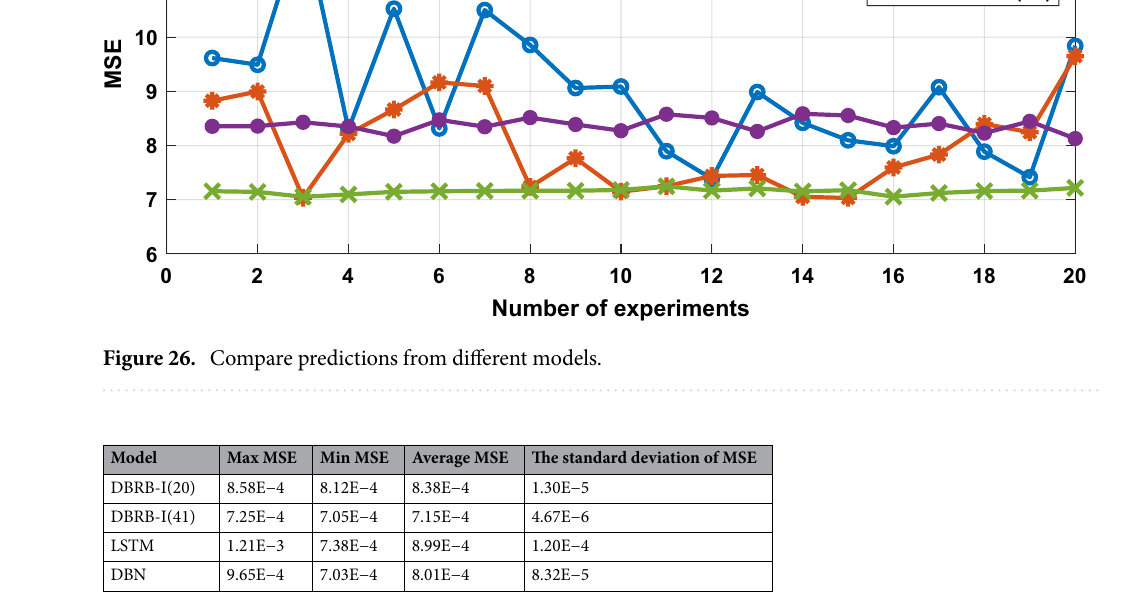
Table 7. Robustness analysis of the model.